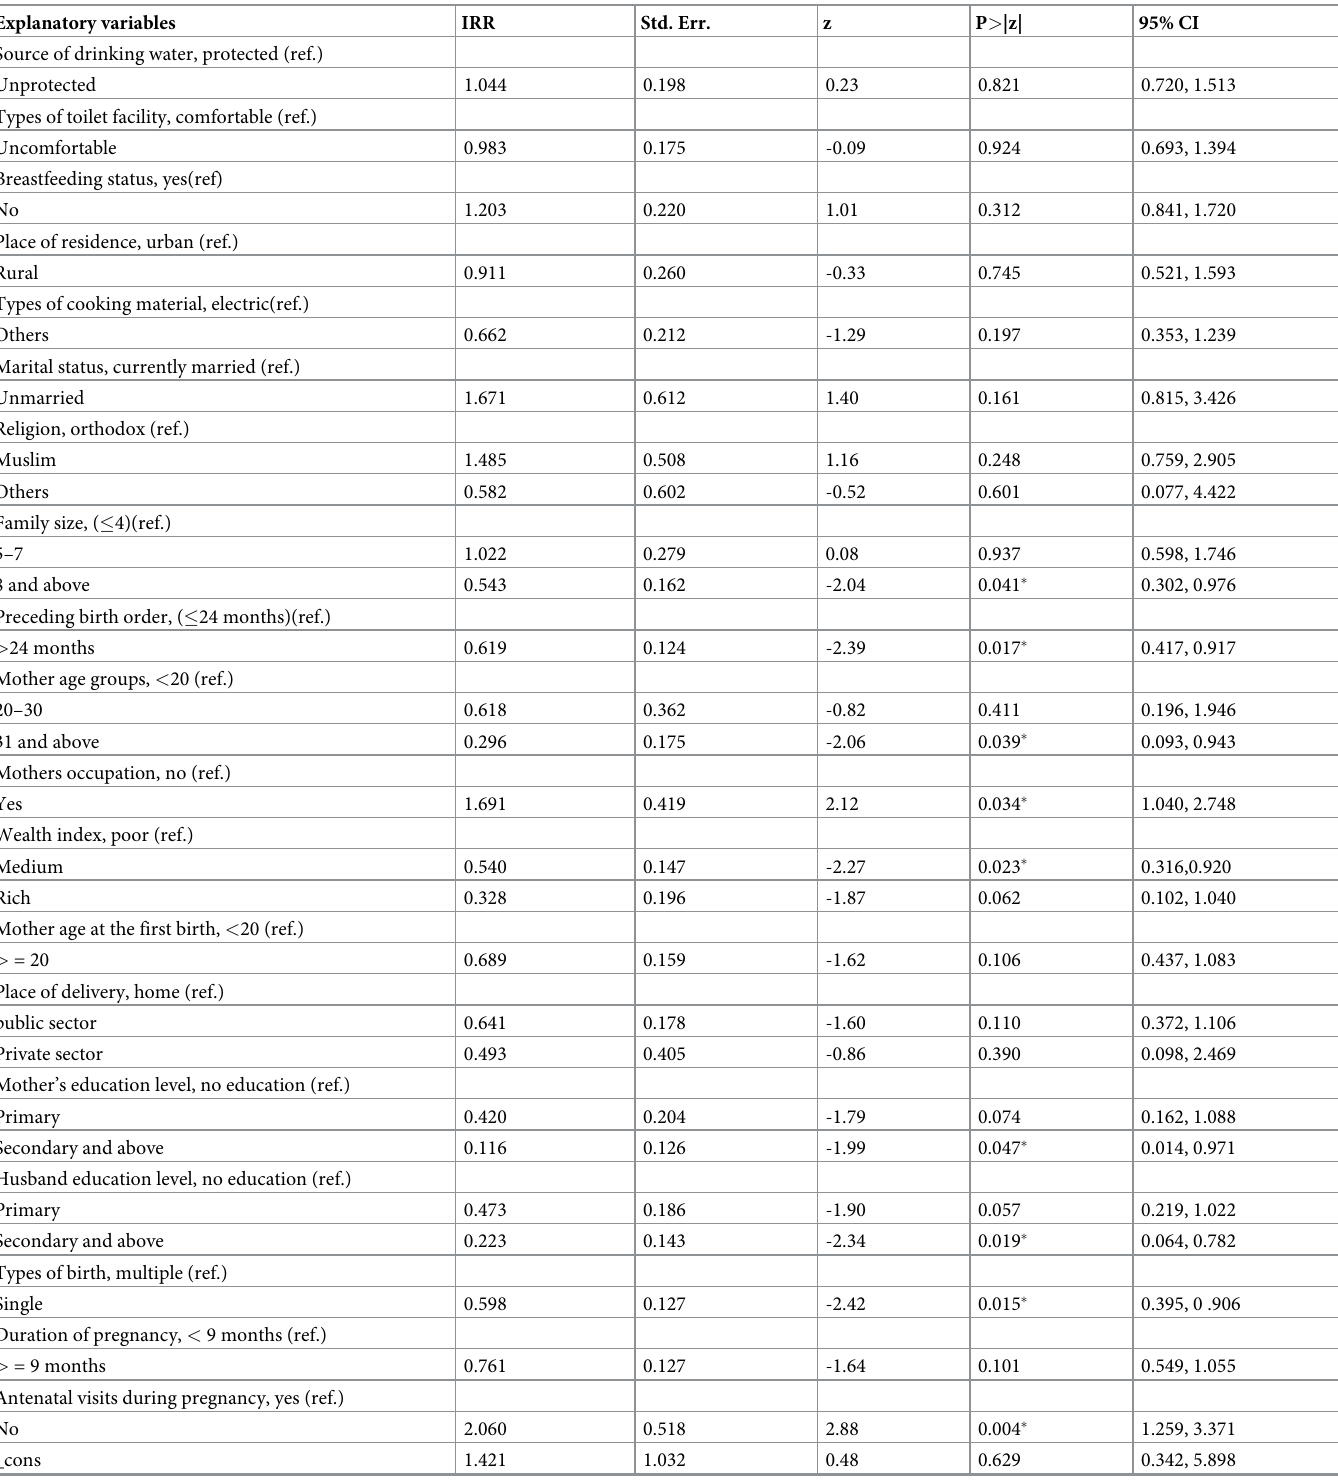
Table 5. ZIP regression model parameter estimation for non-zero